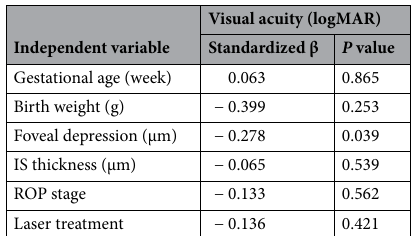
Table 5. Multiple linear regression analysis between visual acuity and independent variables. logMAR: logarithm of the minimum angle of resolution, ROP: retinopathy of prematurity, IS: inner segment.